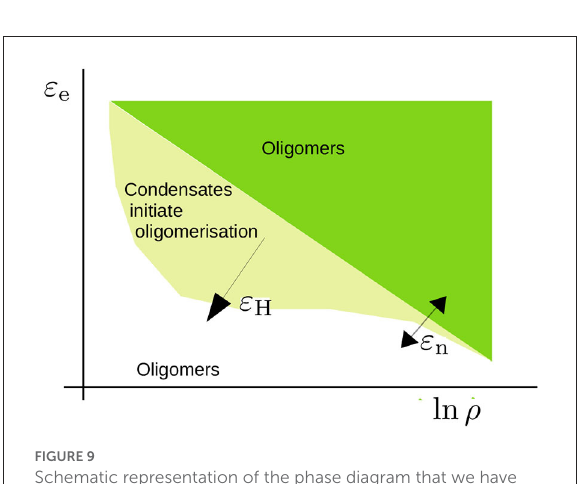
FIGURE9 Schematic representation of the phase diagram that we have studied in the present study. The critical concentration for ε e / k B T with ε e the oligomerisation is roughly given by ln ρ crit ∝ elongation energy. This critical concentration is affected by excluded volume effects near the overlap concentration and leads to an apparent dependence on the nucleation energy ε n (refer to Section 3.1). For a sufficiently high hydrophobic interaction energy ε H , condensates form. The concentration is high within these condensates and promotes oligomer formation. The shape of this region is a qualitative estimate that acknowledges that phase separation takes place within a limited concentration